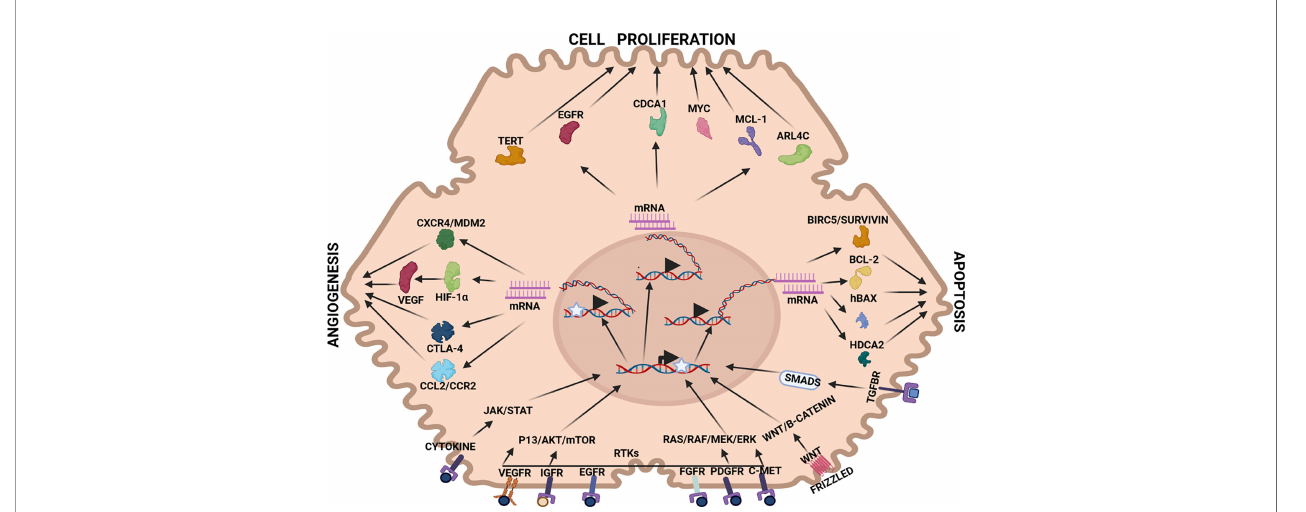
FIGURE 2 | Therapeutic targets in HCC pathways: Angiogenesis: CXCR4/MDM2(chemokine receptor/murine double minute 2 protein), CTLA-4 (constitutively expressed in regulatory T cells), HIF-1 a (hypoxia-inducible factor 1-alpha, a subunit of a heterodimeric transcription factor hypoxia-inducible factor 1 that is encoded by the HIF1A gene), VEGF (vascular endothelial growth factor, stimulates the formation of blood vessels), Cell proliferation: TERT (telomerase reverse transcriptase, a catalytic subunit of telomerase, EGFR (epidermal growth factor receptor), CDCA1 (Cell division cycle associated 1, an oncoantigen), MYC (transcription factor, proto- oncogene), MCL-1 (induced myeloid leukaemia cell differentiation protein), ARL4C (ADP-ribosylation factor-like 4C). Apoptosis: BIRC5/Survivin (baculoviral inhibitor of apoptosis repeat-containing 5 or survivin), BCL-2 (B-cell lymphoma 2, regulatory protein inducing or inhibiting apoptosis), hBAX (human Bcl-2-associated X protein, apoptosis regulator), HDCA2 (histone deacetylase 2, removed acetyl groups from lysine at the N ’ terminal of core histones). Receptors: VEGFR (vascular endothelial growth factor receptor), IGFR (insulin-like growth factor receptor), EGFR (epithelial growth factor receptor), FGFR ( fi broblast growth factor receptor), PDGFR (platelet- derived growth factor receptor), C-MET (tyrosine-protein kinase Met or hepatocyte growth factor receptor (HGFR)), WNT (Wingless and Int-1). Pathways: JAK/STAT (Janus kinase ( JAK )-signal transducer and activator of transcription ( STAT )), P13/AKT/mTOR (phosphatidylinositol-3-kinase ( PI3K )/ Akt and the mammalian target of rapamycin ( mTOR ) signalling pathway), RTKs (receptor tyrosine kinases), RAS/RAF/MEK/ERK (extracellular signal-regulated kinases), WNT/B-CATENIN (highly conserved